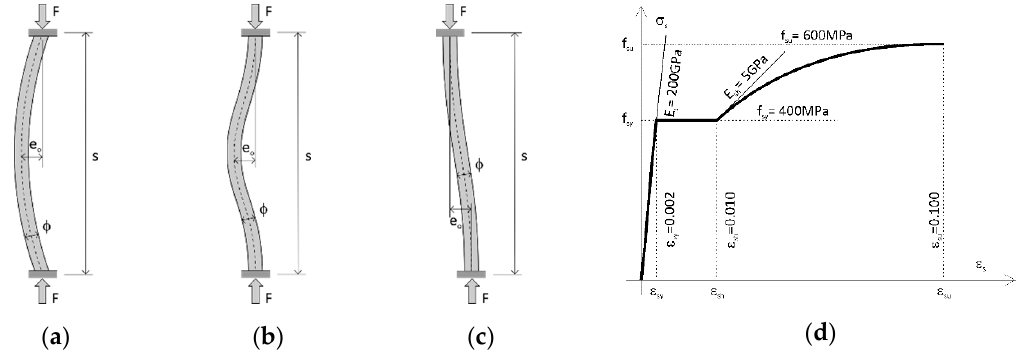
Figure 3. Reinforcing bars models for: ( a ) bending deformation (MD), ( b ) compression deformation (ND), ( c ) shear deformation (VD) and ( d ) material curve.